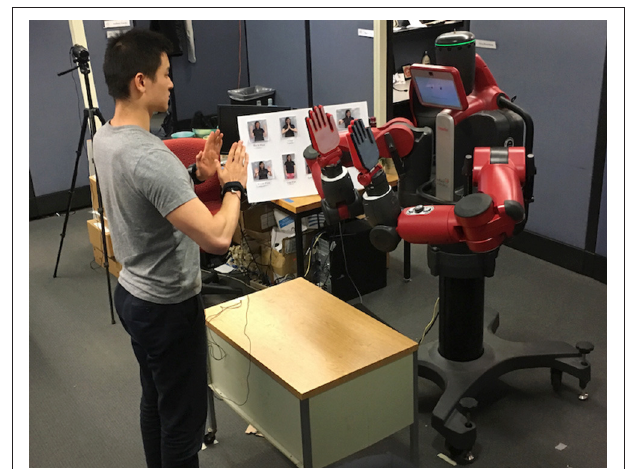
FIGURE 5 | The experiment setup for the bimanual human-robot hand-clapping study. The individual shown in this image provided written consent for this image to be